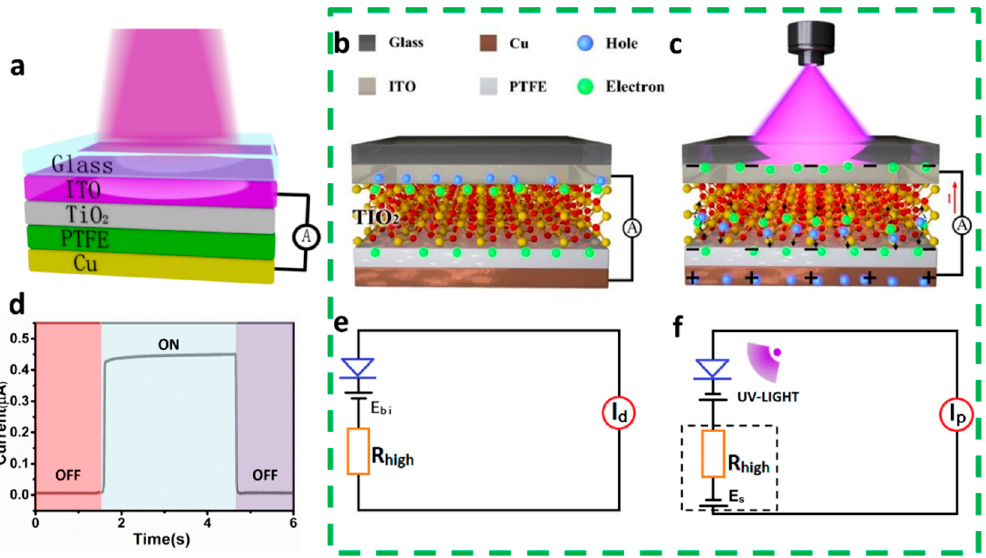
Figure 1. The device structure and working mechanism. ( a ) Design of the IEFB-SP ultraviolet photodetector. Working mechanism of the IEFB-SP device in light-off ( b ) and light-on ( c ) states. ( d ) Photocurrent of one switching cycle with 365-nm wavelength and illumination of 0.64-mW/cm2 at a bias of 0 V. Equivalent circuit diagram of the device in light-off ( e ) and light-on ( f ) states.